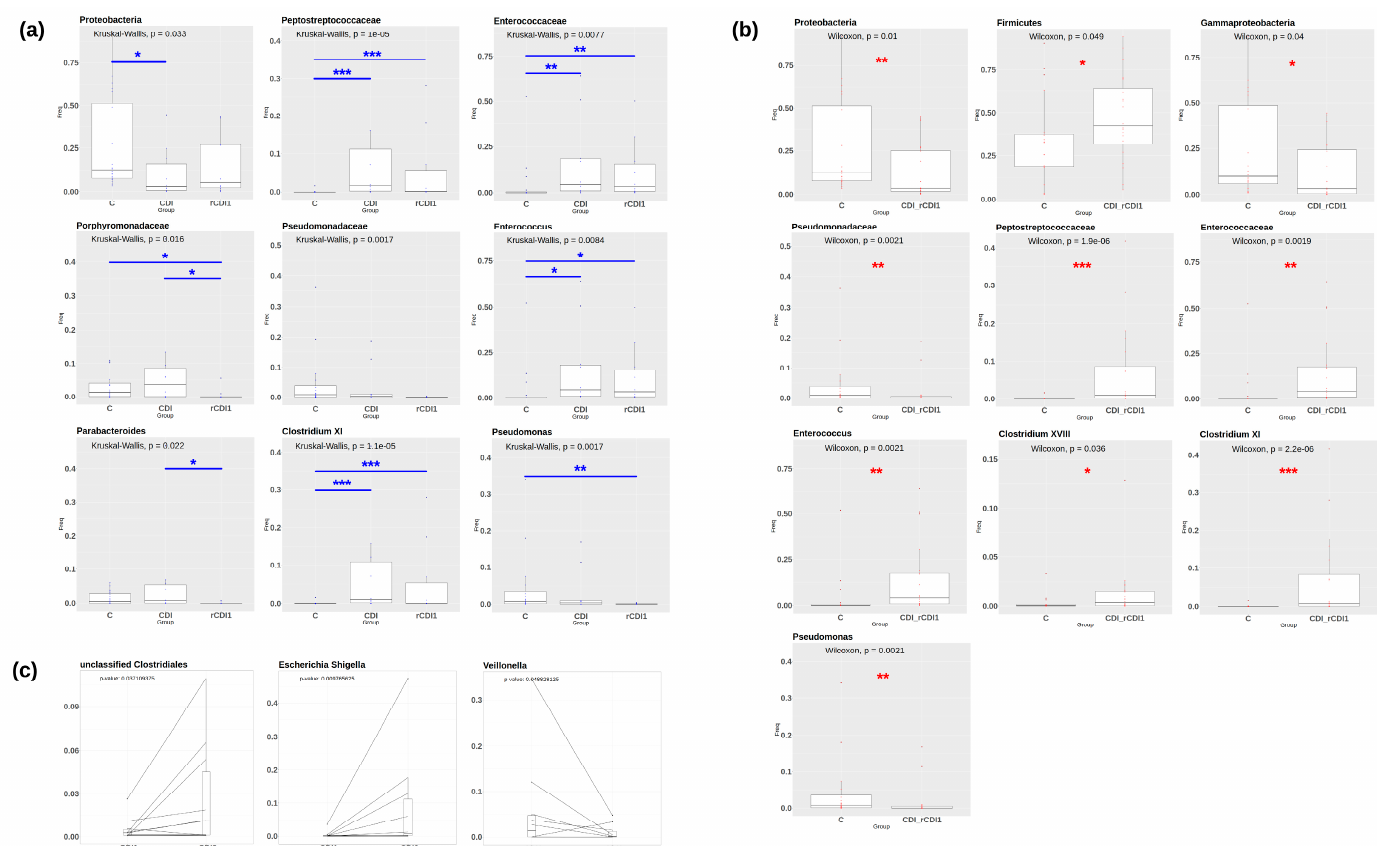
Figure 2. Taxa displaying significantly different relative abundances in the following comparisons: C vs. CDI vs. rCDI1 ( a ); C vs. CDI + rCDI1 ( b ); rCDI1 vs. rCDI2 ( c ). Pairwise comparisons producing significant p -values are indicated as * ( p < 0.05); ** ( p < 0.01); *** ( p < 0.001). The cut-off value for taxa prevalence was set at 10%. Comparisons between patient categories are indicated over the boxplots. Values for paired Wilcoxon (C) are indicated in red. C = non-infected controls; CDI = non-recurrent C. difficile infection; rCDI1 = recurrent C. difficile infection, first episode; rCDI2 = recurrent C. difficile infection, second episode.